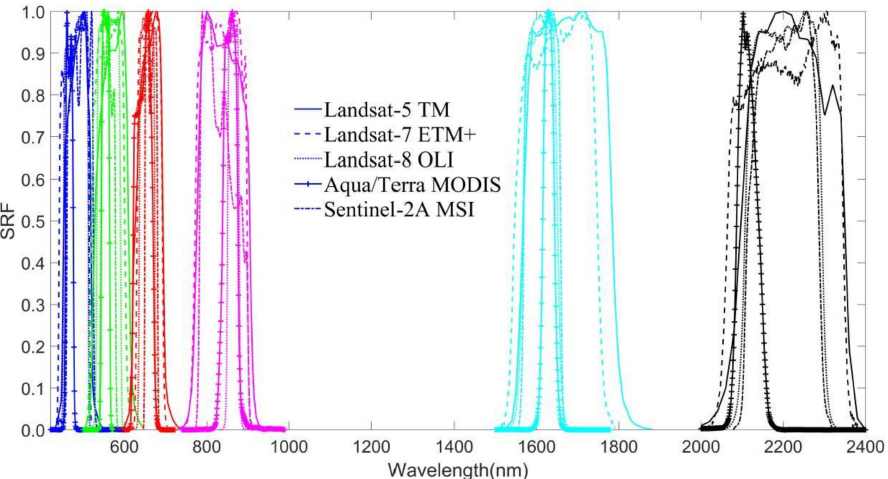
Figure 5. The spectral response functions (SRF) of TM, ETM+, Operational Land Imager (OLI), Moderate- Resolution Imaging Spectroradiometer (MODIS), and Multi-Spectral Instrument (MSI)